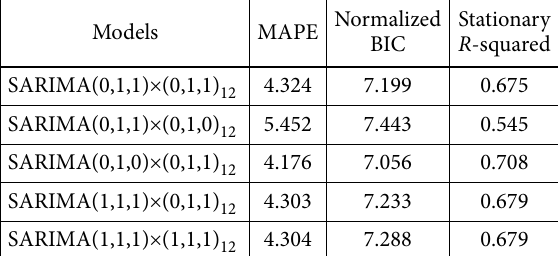
Table 1. Normalized BIC, MAPE and stationary R-squared